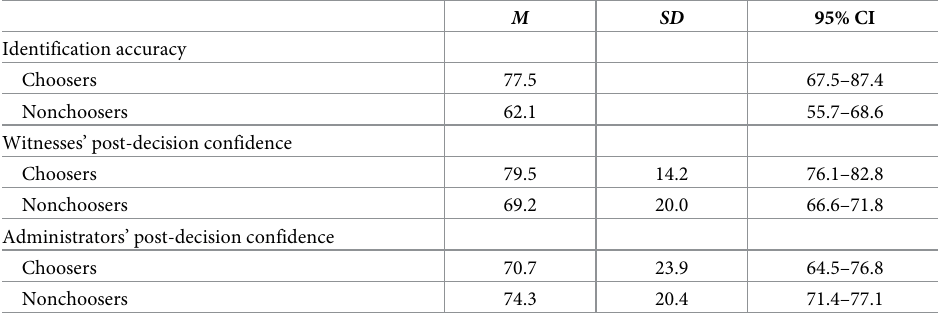
Table 1. Descriptives of choosers’ and nonchoosers’ identification accuracy and witnesses’ and lineup administra- tors’ post-decision